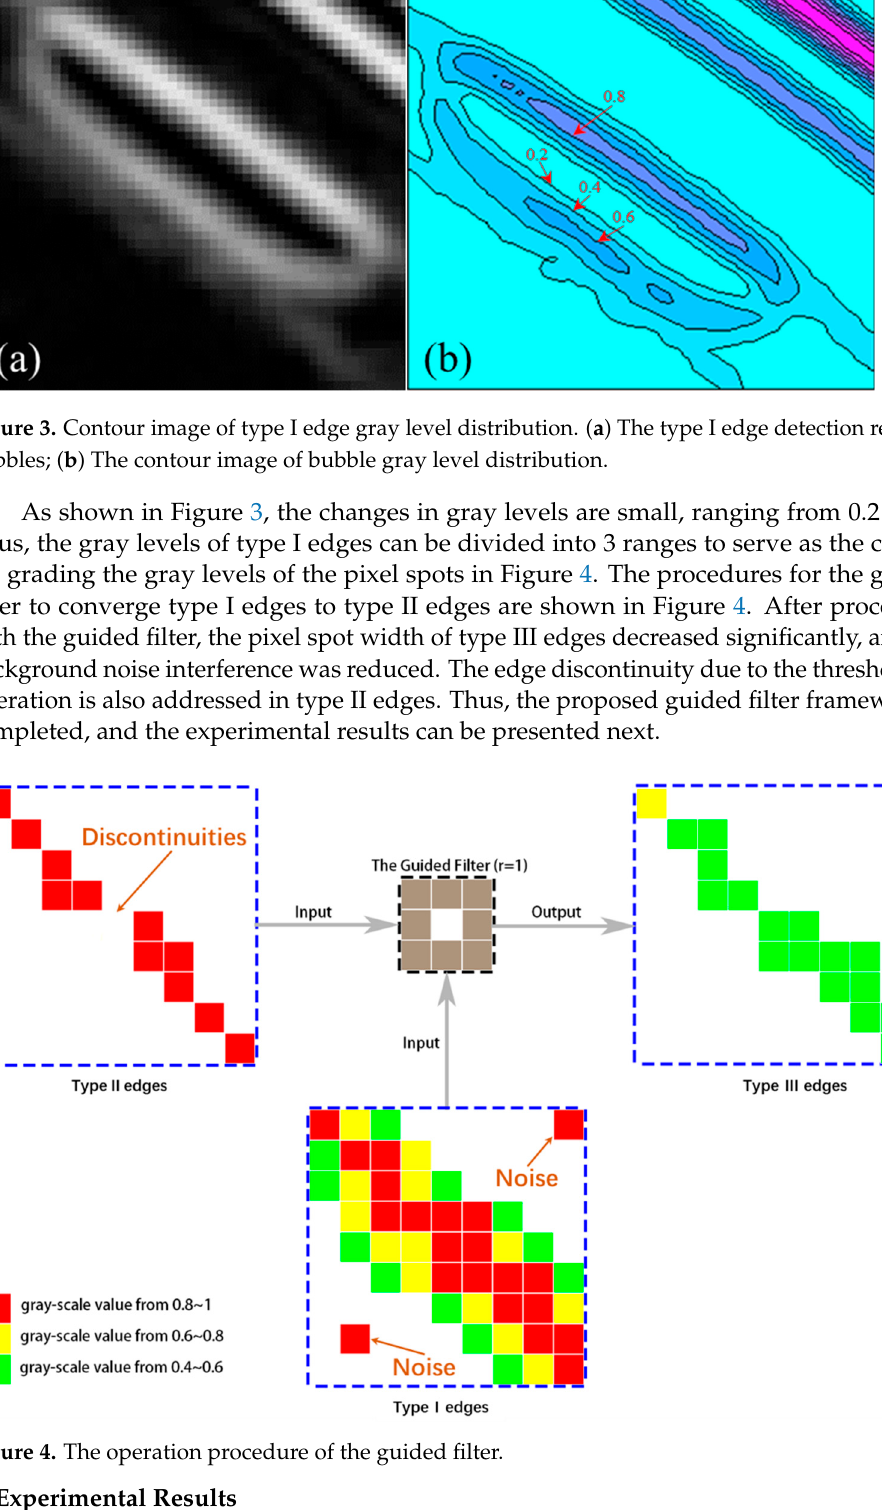
( b ) Figure 5. ICT images of propellant defects: ( a ) Image of cracks and bubbles; ( b ) Image of slags. Type I, II, and III edges of typical defects are presented in Figure 6, where (a), (b), and (c) shows type I, II, and III edges of crack II; (d), (e), and (f) shows type I, II, and III edges of Bubble I; (g), (h), and (i) shows type I, II, and III edges of Slag I. The quality of type III edges with each type of defect is higher than that of type I and II edges, which aligns with the desired goal of better continuity and better noise reduction.